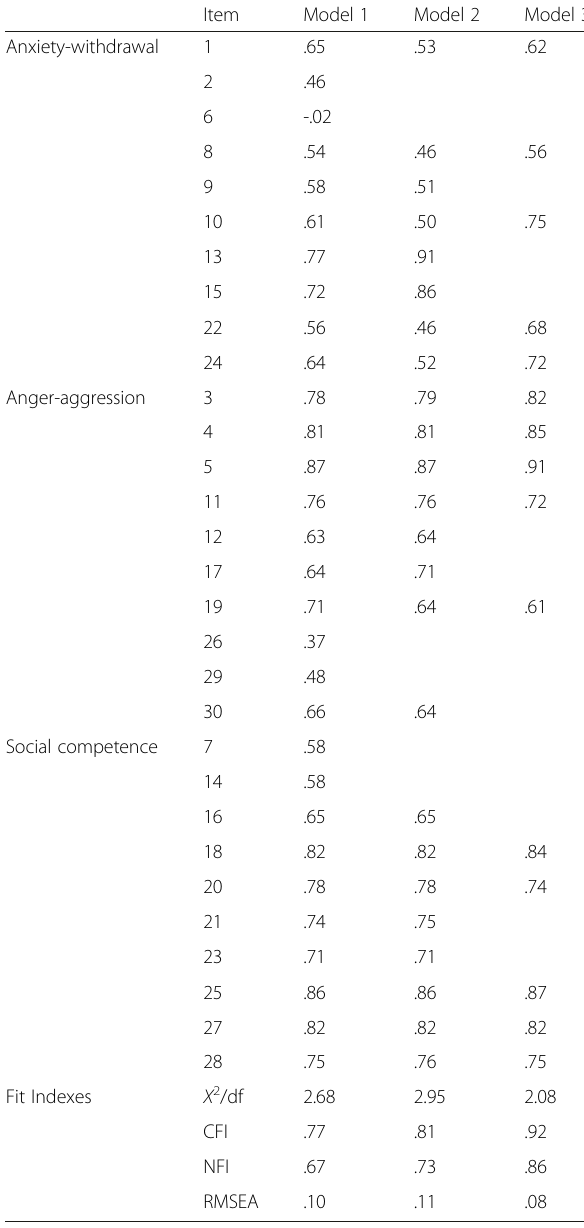
Table 1 Factor loadings for the main models tested using an exploratory approach (subsample